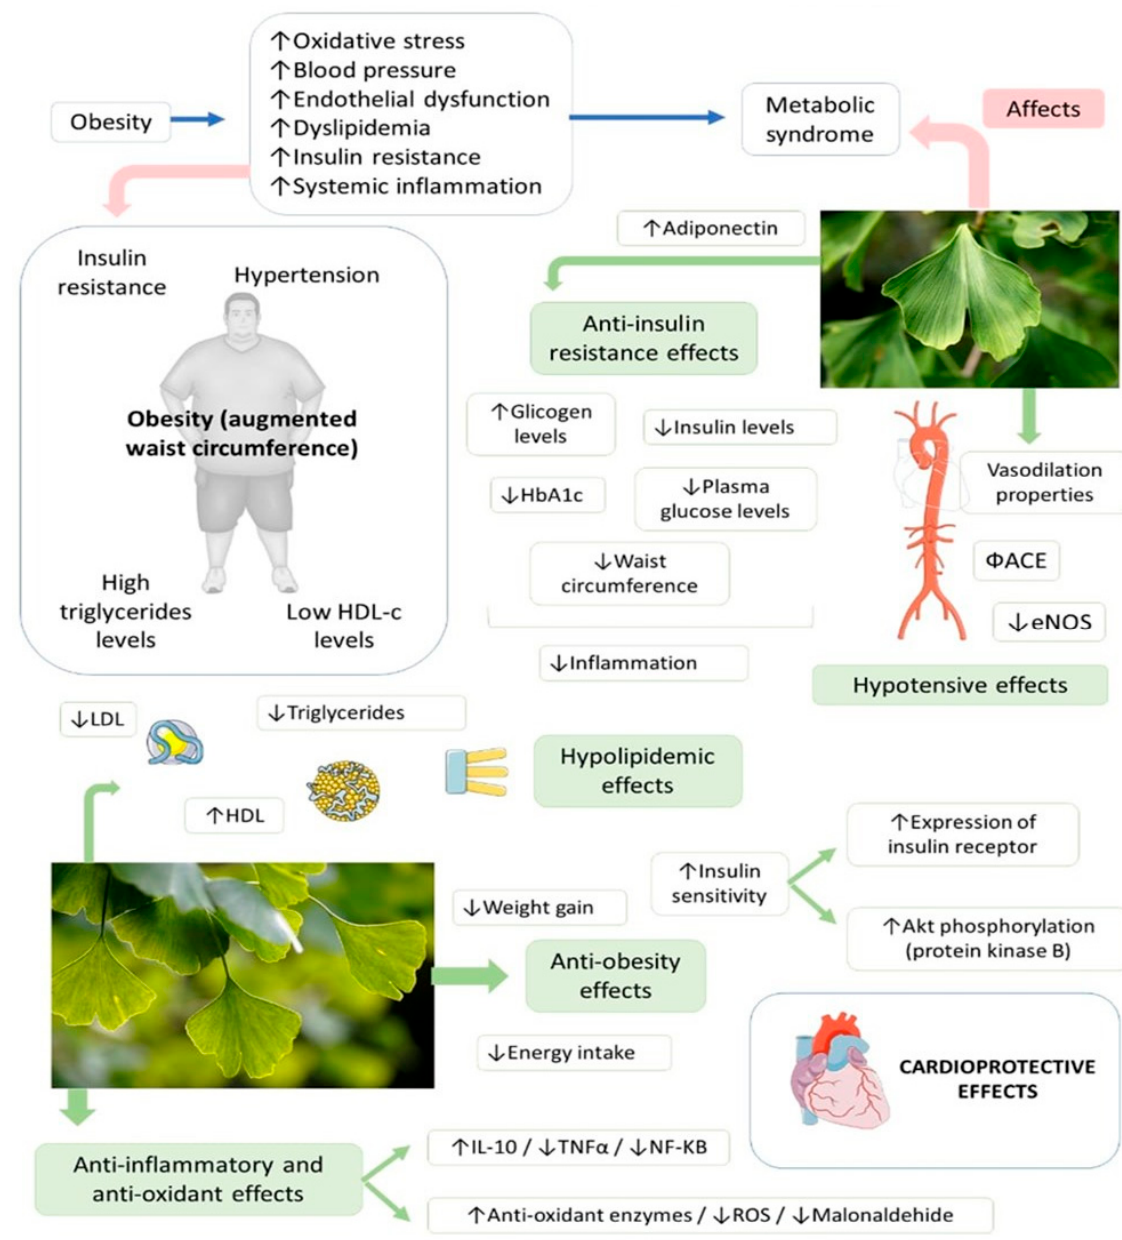
Figure 4. Ginkgo biloba and its extracts have many effects against cardiovascular risk factors that compound metabolic syndrome. ↑ —increase; ↓ —decrease; Φ —inhibition; ROS—reactive oxygen species; TNF- α —tumor necrosis factor; IL-10—interleukin 10; NK-KB—factor nuclear kappa B;